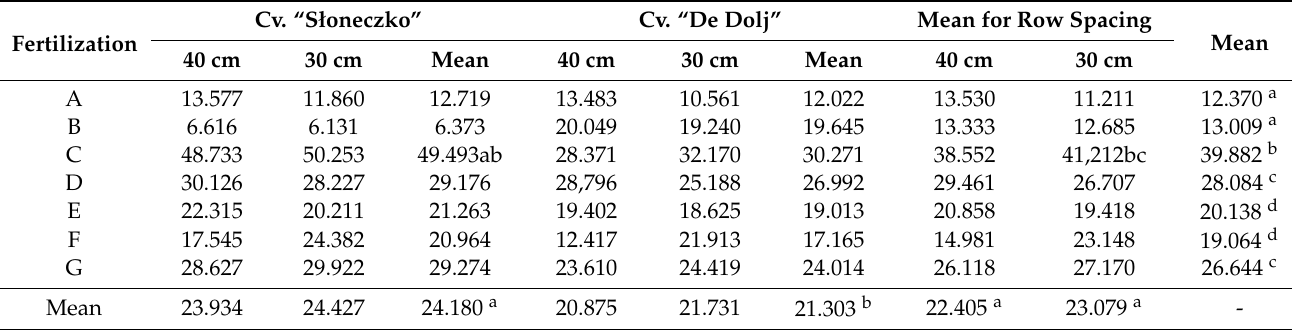
Table 9. Reducing power of extracts (FRAP) determined in thyme raw material ( µ M TE g − 1 ). Cv. Fertilization